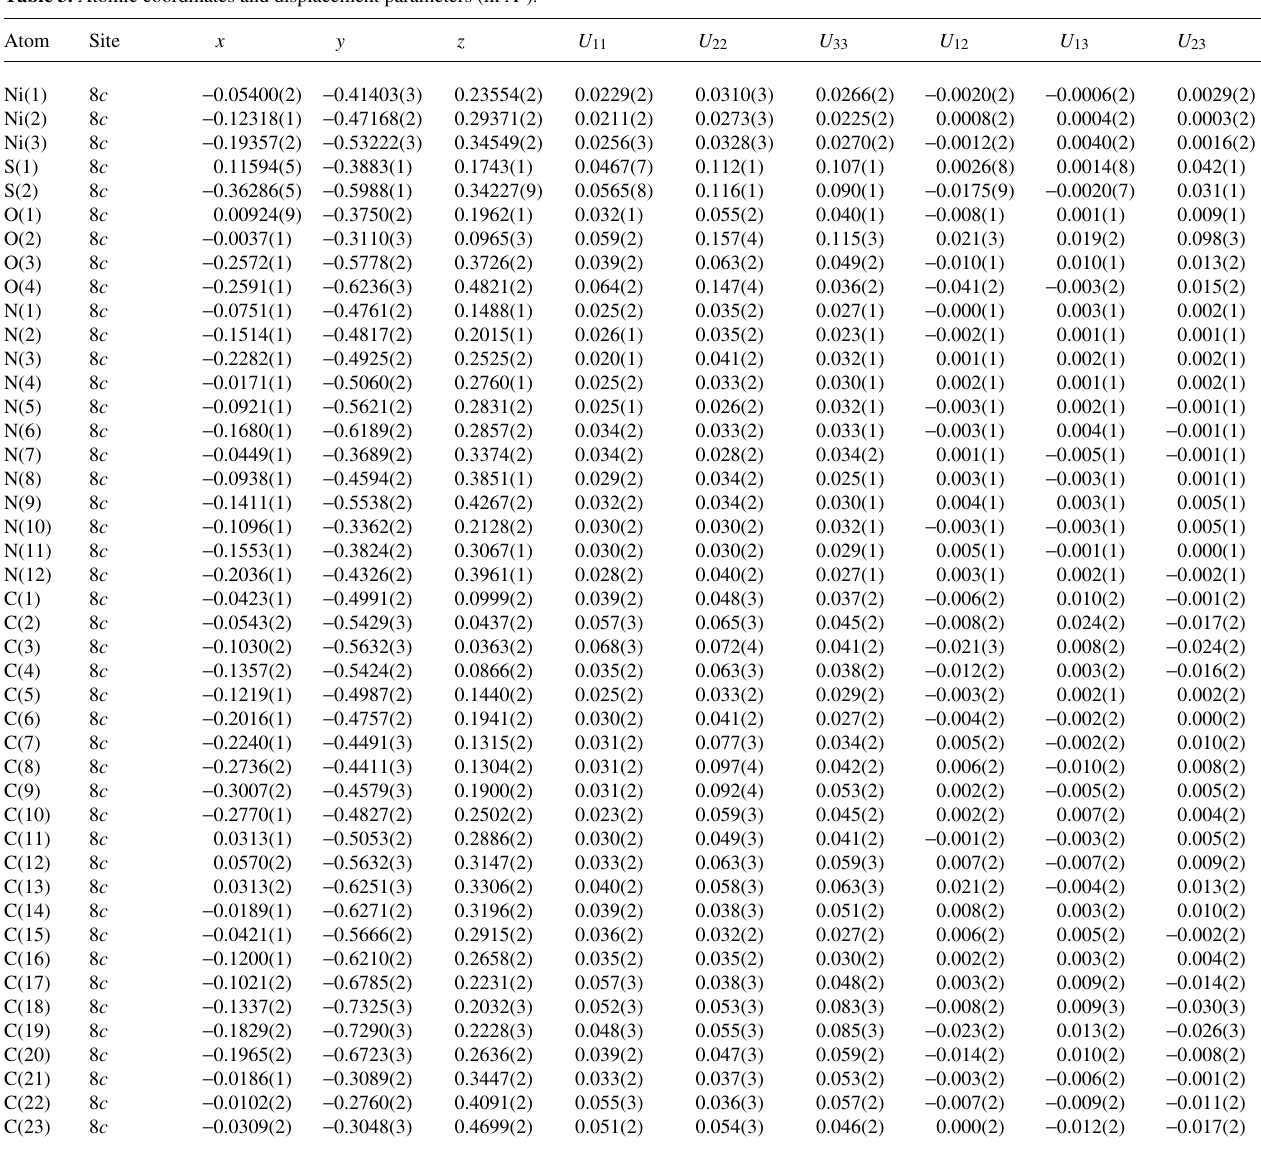
Table 3. Atomic coordinates and displacement parameters (in Å 2 ) .